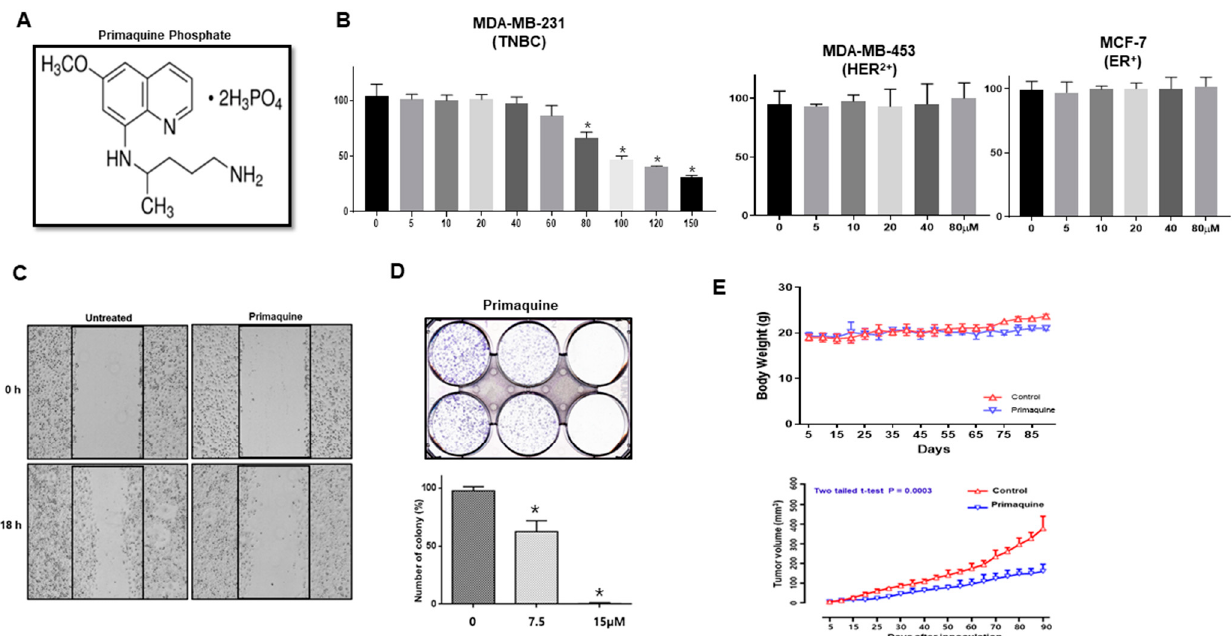
Figure 1. Effect of primaquine on breast cancer hallmarks and on tumor growth in a nude mouse model. ( A ) Molecular structure of primaquine phosphate. ( B ) The proliferation of breast cancer cells was measured using an MTS assay kit and the CellTiter 96 Aqueous One Solution kit. Breast cancer cells were incubated in 96-well plates in the presence of primaquine (5, 10, 20, 40, 80, 100, 120, and 150 µ M and DMSO). Values are the mean ± standard deviation (SD) of 3 independent experiments. * indicates p < 0.05 vs. control. ( C ) Effect of primaquine on the migratory ability of breast cancer. The migration of MDA-MB-231 cancer cells with/without primaquine was photographed at 0 and 18 h. ( D ) Effect of primaquine on the colony formation of breast cancer cells. Two thousand MDA-MB-231 cells were cultured in 6-well plates with/without primaquine at the indicated concentrations for one week. Representative image of colonies. Values are mean ± SD of 3 independent experiments. * indicates p < 0.05 vs. control. ( E ) The effect of primaquine on tumor growth in a xenograft mouse model. A total of 2 × 10 6 cancer cells were injected into the mammary fat pad of each nonobese diabetic/severe combined immunodeficiency (NOD/SCID) female nude mouse. Effect of tumor growth on primaquine and MDA-MB-231 cell-bearing immunodeficient nude mice. The dose of drug used was 2 mg/kg once every 10 days. Tumor volume was measured once every 10 days using a caliper and calculated as (width 2 × length)/2. Tumor growth curves were monitored during the experimental period.